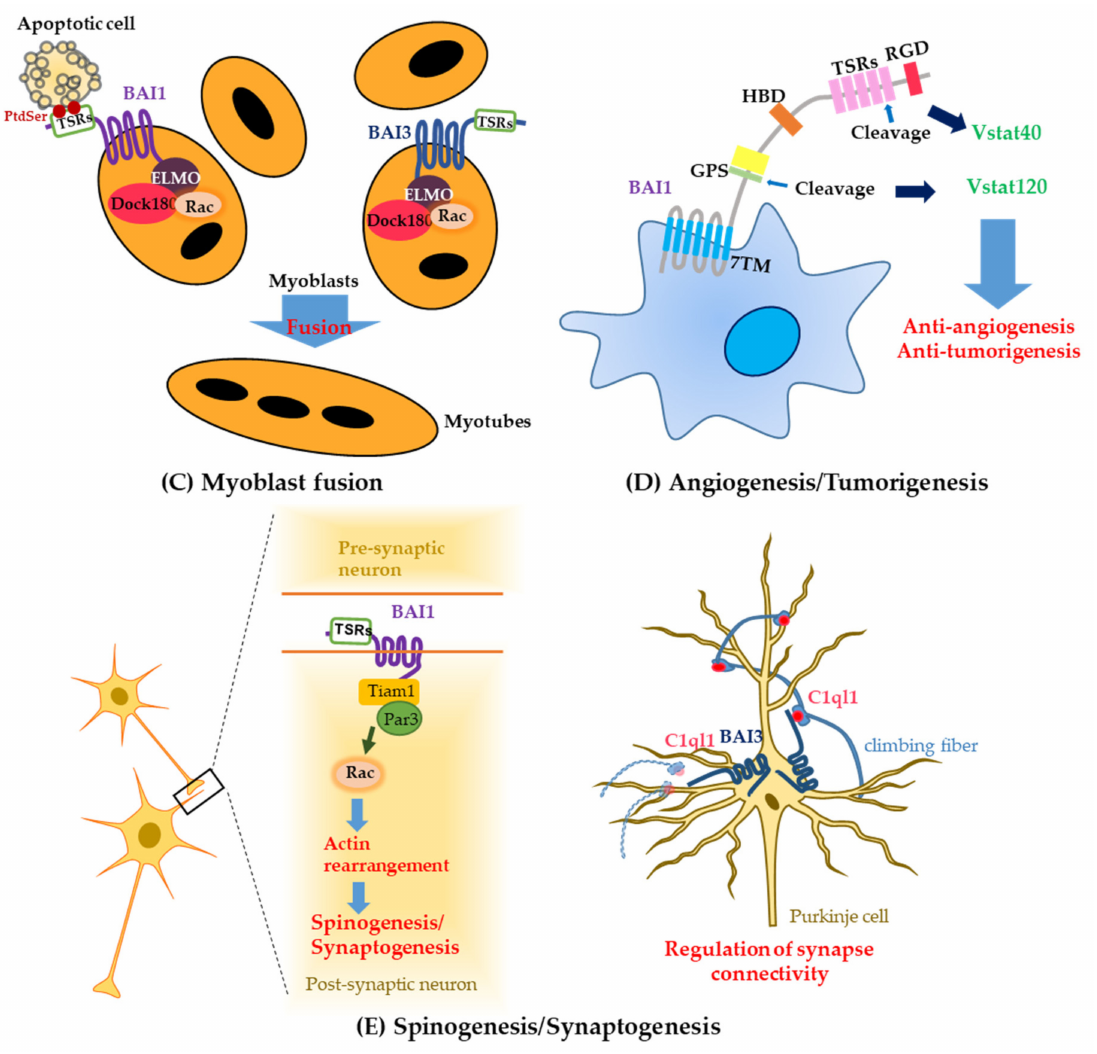
Figure 2. Functions of the BAI subfamily. ( A ) BAI1 as an engulfment receptor; ( B ) BAI1 as a pattern recognition receptor; ( C ) BAI1 and -3 as the mediators of myoblast fusion; ( D ) BAI1 as an inhibitor of angiogenesis and tumorigenesis; ( E ) BAI1 and -3 as modulators of synaptogenesis and